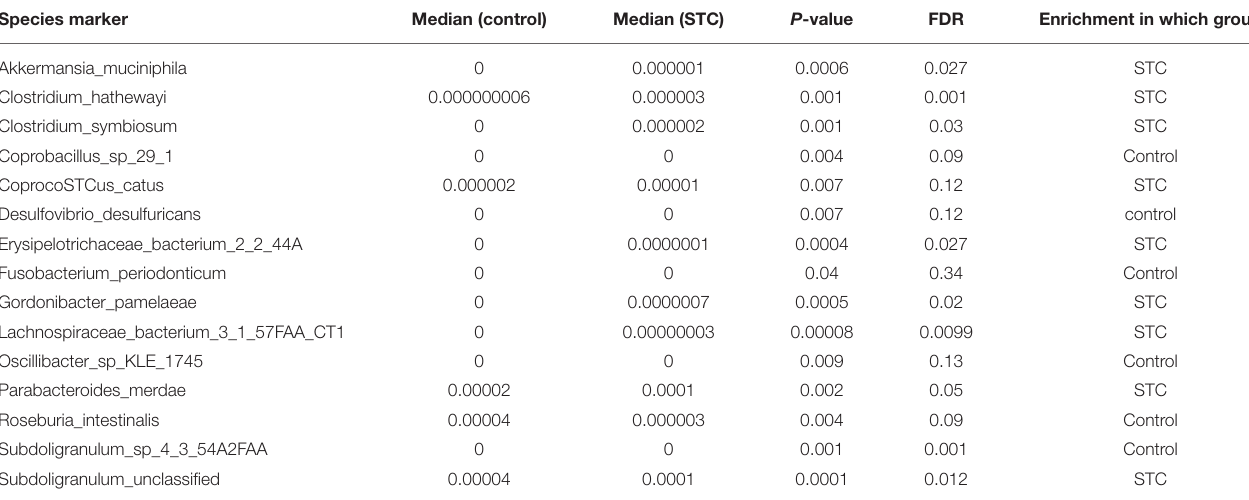
TABLE 3 | The best 15 species markers in the ROC curve picked from the 59 differential species markers. Species